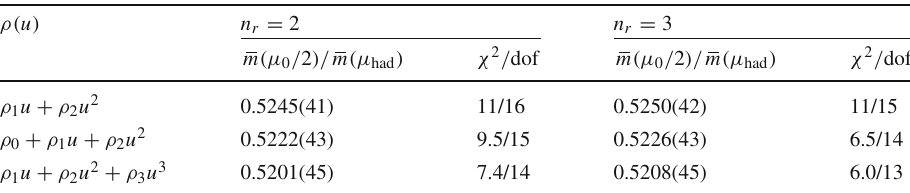
Table 3 Results for the running factor m (μ 0 / 2 )/ m (μ had